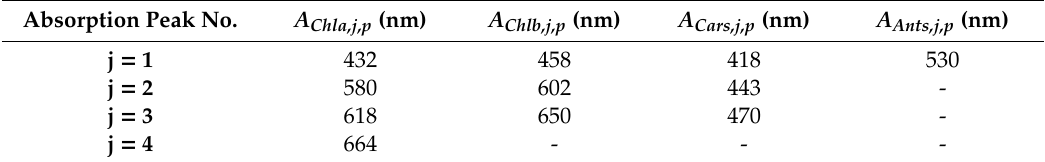
Table 2. The number and position of absorption peak for pure pigment in the 400–800 nm region from a mixed organic